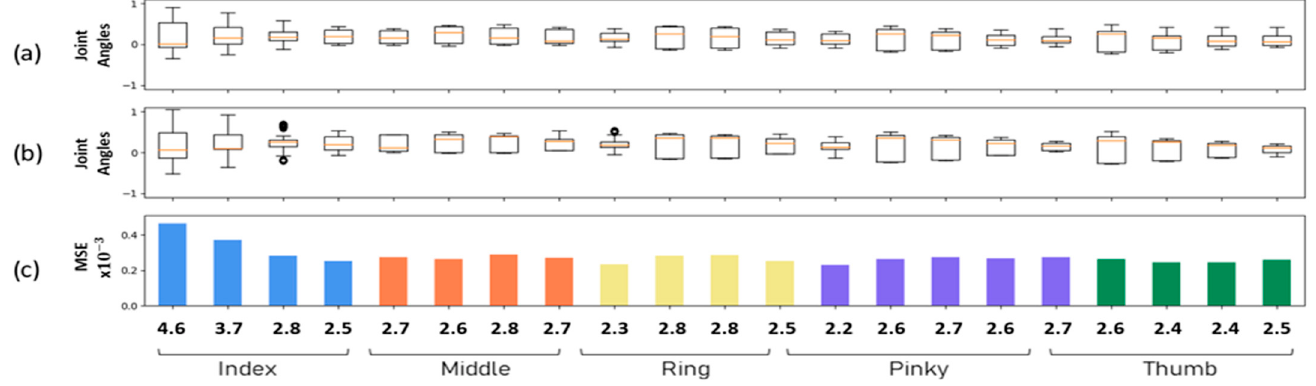
Figure 3. The mean squared error ( c ) between the joint angle distributions of the ContactPose dataset ( a ) and the angles’ distributions as estimated by the transformer network ( b ) for each finger in the anthropomorphic hand. A lower error indicates higher confidence in estimation.